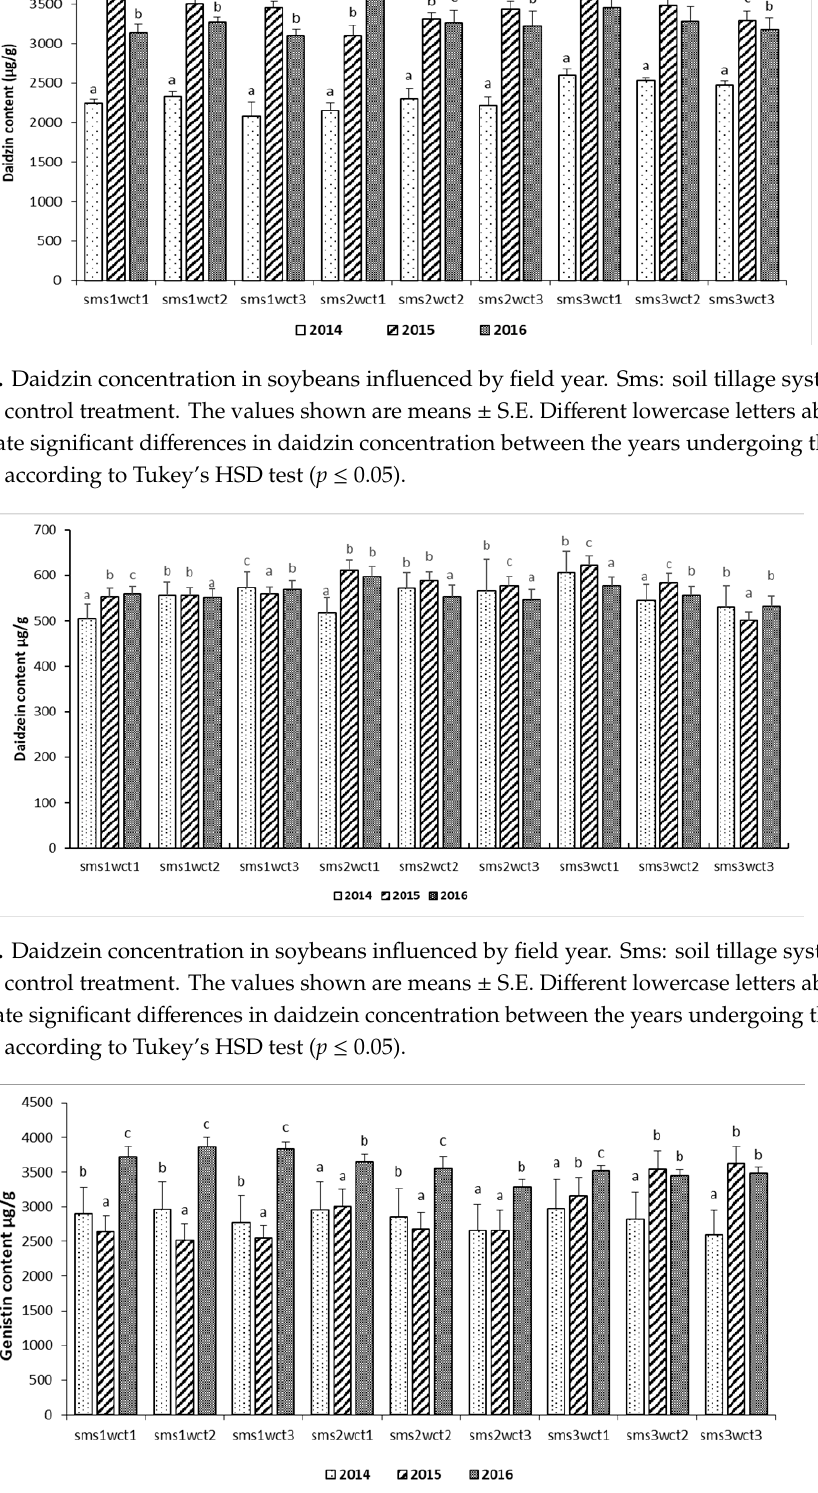
Figure A5. Genistein concentration in soybeans influenced by field year. Sms: soil tillage system and wct: weed control treatment. The values shown are means ± S.E. Different lowercase letters above the bars indicate significant differences in genistein concentration between the years undergoing the same treatment, according to Tukey’s HSD test ( P ≤ 0.05).